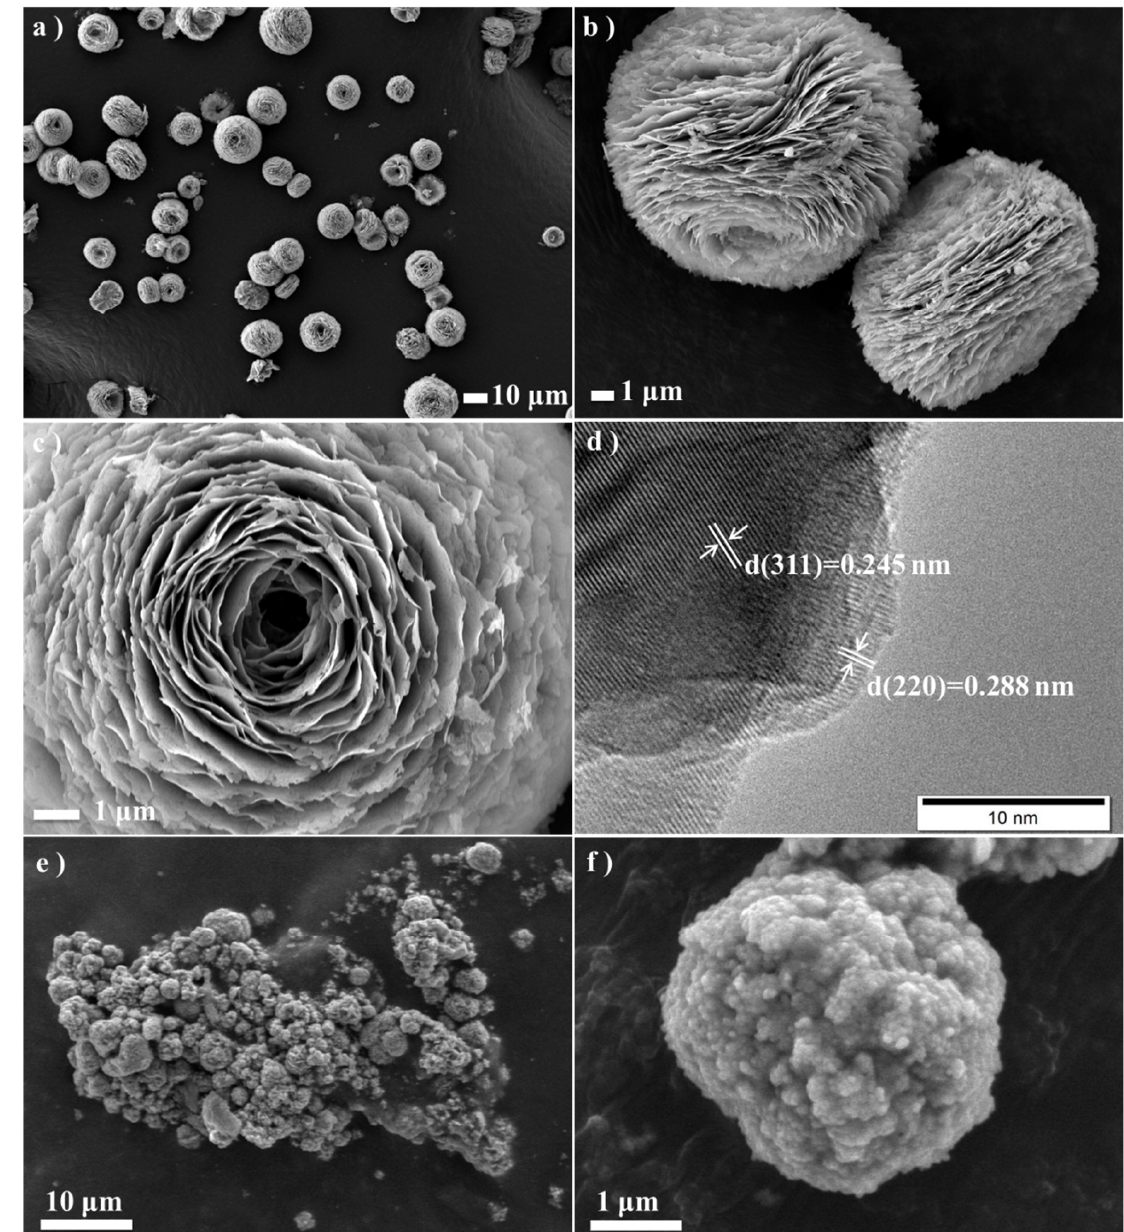
Figure 2. SEM images of the Co 3 O 4 -FL catalysts at low ( a ) and high ( b , c ) magnifications, TEM image of the Co 3 O 4 -FL catalysts ( d ), and SEM images of the Co 3 O 4 -C catalysts at low ( e ) and high ( f ) magnifications.